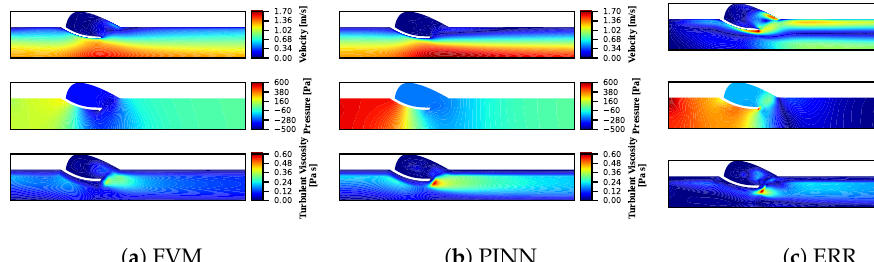
Figure A5. Turbulent flow: 55 degree valve.